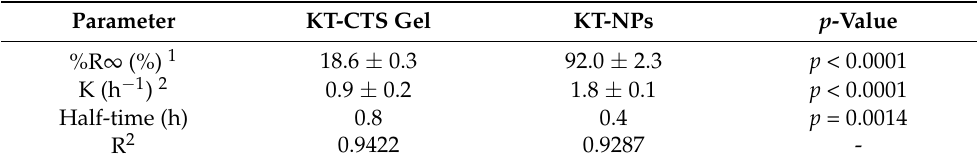
Table 3. Parameters of KT release from KT-CTS gel and KT-NPs according to first-order kinetics. Values are expressed as the Mean ± standard deviation ( n =